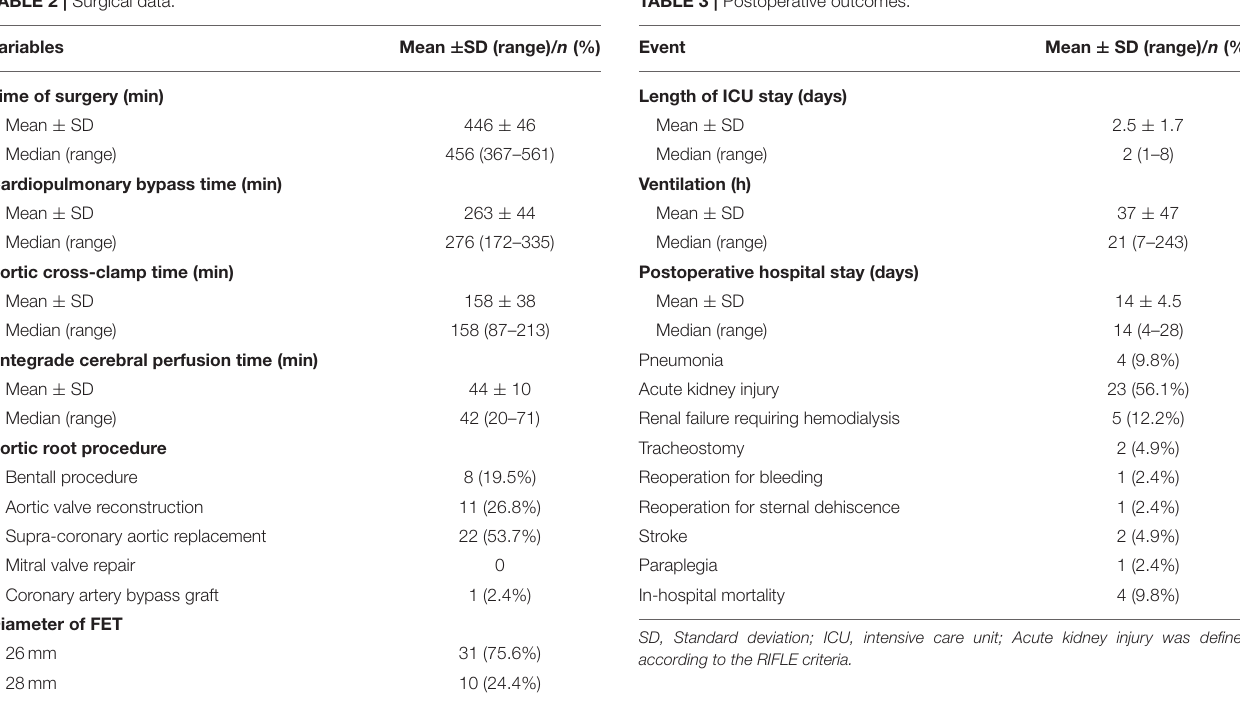
TABLE 2 | Surgical data. TABLE 3 | Postoperative